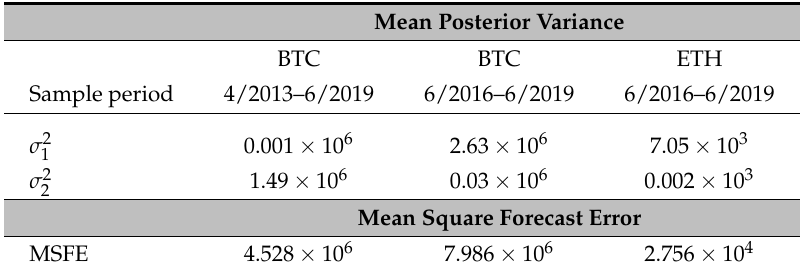
Table 2. Measures of in-sample and out-of-sample estimation: mean posterior variance of the two states and mean square forecast error for the three